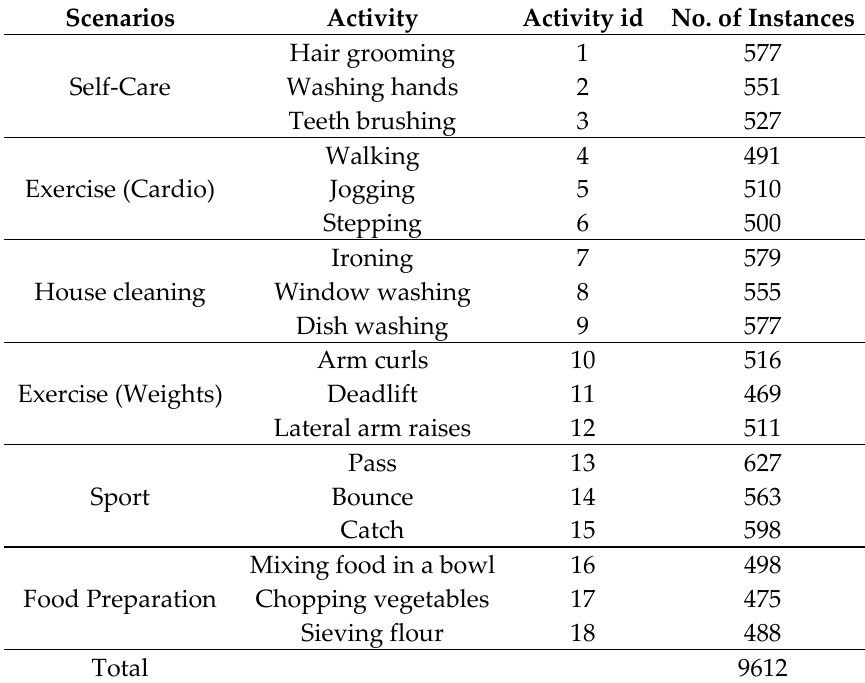
Table 1. Activities grouped by scenarios with their ids and the No. of instances.